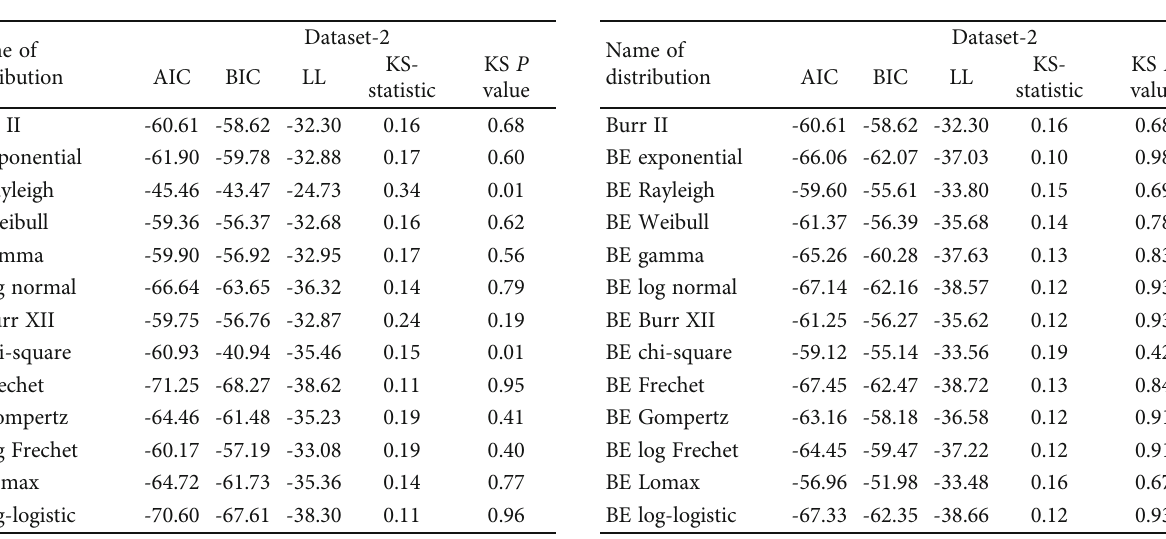
Table 19: Comparison of BT-IID with class of EGDs using dataset-2.